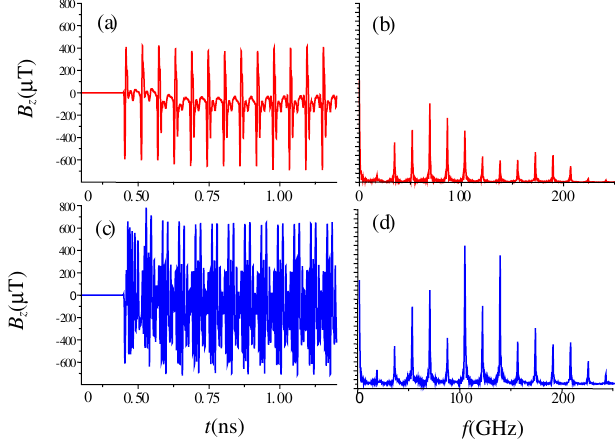
(cid:2) t (cid:4) and (b) its FFT z